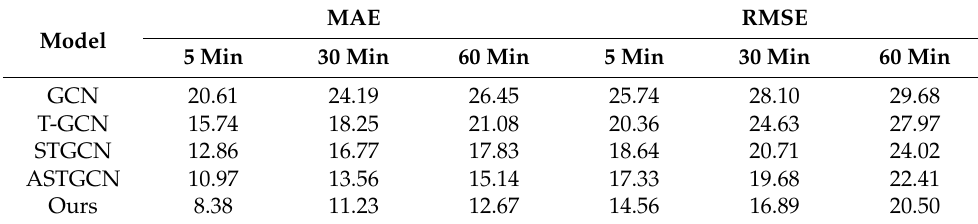
Table 1. Results of the evaluation of different flow prediction